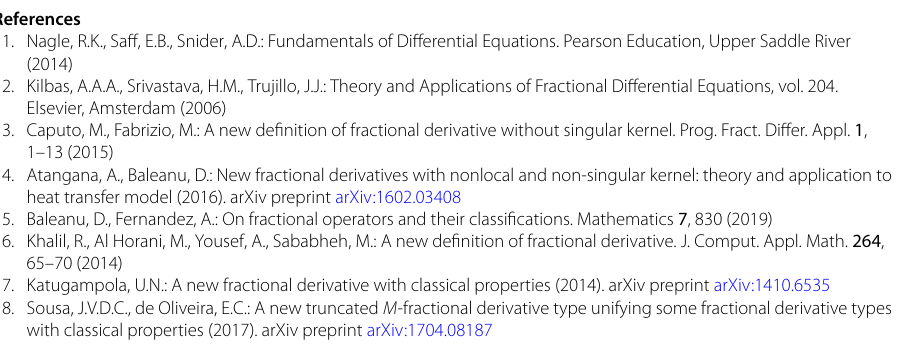
conformable derivative correspond to the classical solution of the model analyzed when α = 1